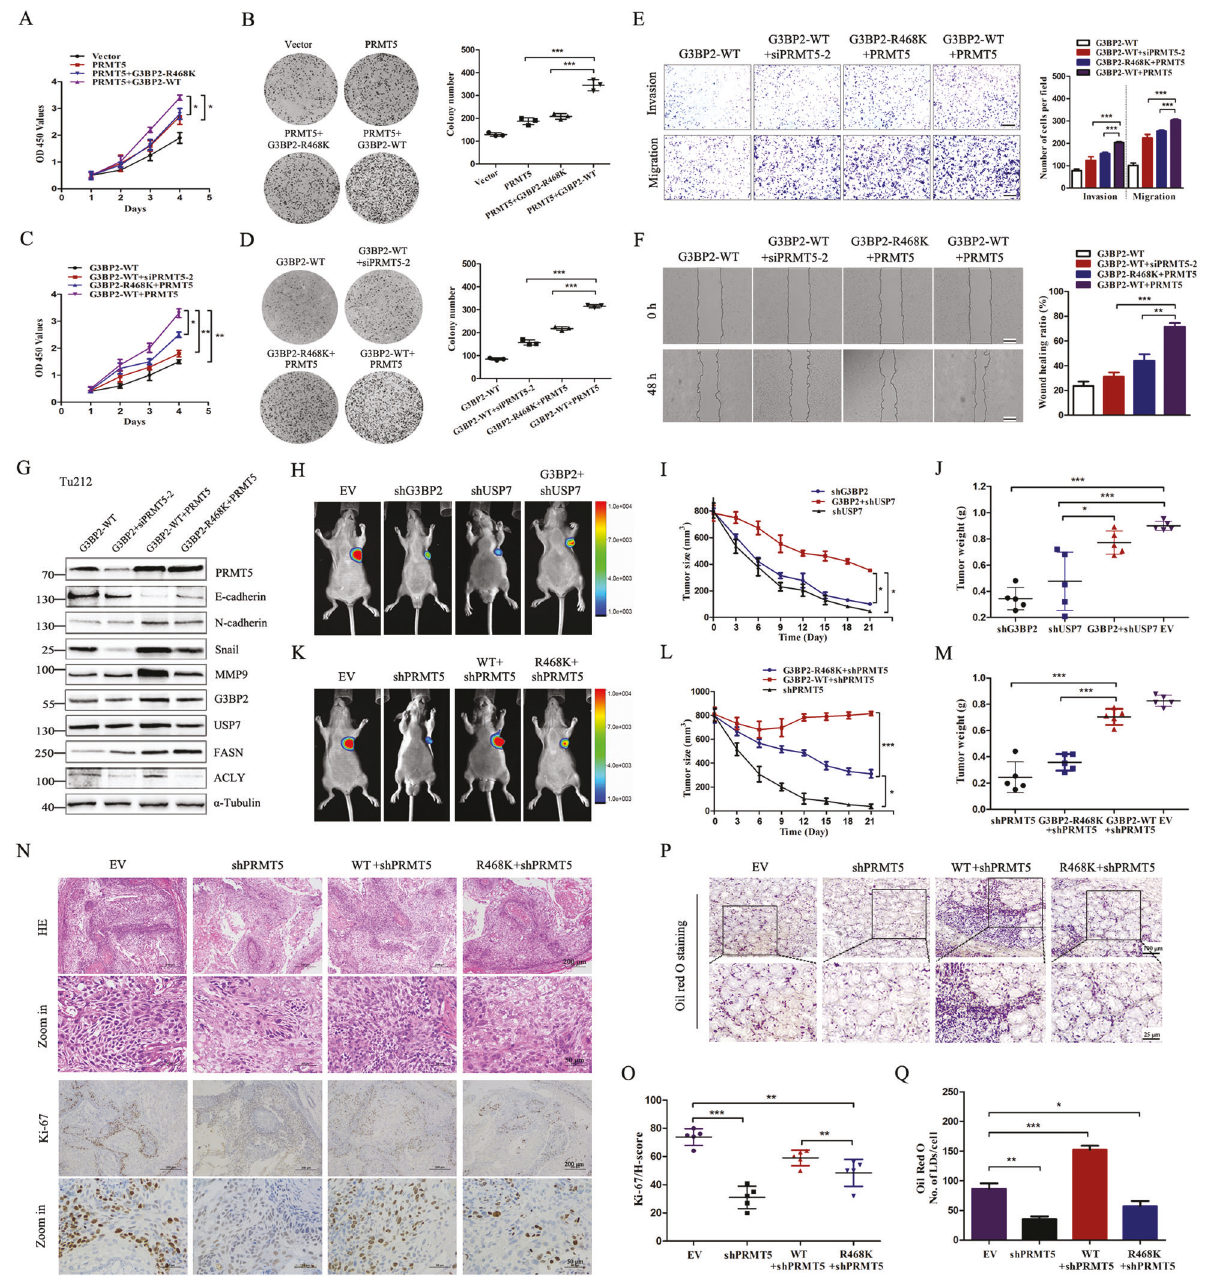
Fig. 6 PRMT5-USP7-G3BP2 axis is required for tumorigenesis of HNSC. A , C Cell viability was analyzed by Cell counting kit-8 (CCK-8). B , D Colony formation assays were performed to evaluate the proliferation ability of the cells with indicated treatments. Cells were seeded into six-well plates at a density of 1000 cells/well, and cultured for 12 d, and then stained with crystal violet. The colonies were captured and counted. E Transwell migration and invasion assays were used to estimate the migration and invasion ability of G3BP2-WT and G3BP2-R468K with or without PRMT5 expression. Representative pictures are shown on the left, and quanti fi cations on the right. Scale bar: 100 μ m. F Representative pictures shown the wound healing assays of G3BP2-WT and G3BP2-R468K with or without PRMT5 expression. Scale bar: 100 μ m. G Immunoblotting analysis validated the protein expression levels of EMT and lipid metabolic-related markers. H Representative images of tumor-bearing nude mice. Tu686 cells were treated as indicated, such as EV, shG3BP2, shUSP7, and G3BP1 + shUSP7, and then injected into nude mice ( n = 5). I Tumor diameters were measured every 3 days, and tumor volumes were calculated. J Average tumor weight of the xenografts in each group were weighed. K Representative images of tumor-bearing nude mice. G3BP2-WT and G3BP2-R468K overexpression Tu686 cells with shPRMT5 were respectively injected into nude mice ( n = 5). L , M Tumor diameters and tumor volumes were calculated. N The levels of proliferation marker of Ki-67 were examined in different groups of tissues. Scar bar: 200 μ m; 50 μ m. O The H score of Ki-67 in different groups. P Representative images of Oil red O staining of tumor tissues from nude mice. scale bar: 100 μ m; 25 μ m. Q The quanti fi cation of the number of lipid droplets per cell among 200 cells in different groups. The data are presented as the mean ± SD * P < 0.05, ** P < 0.01, *** P < 0.001.